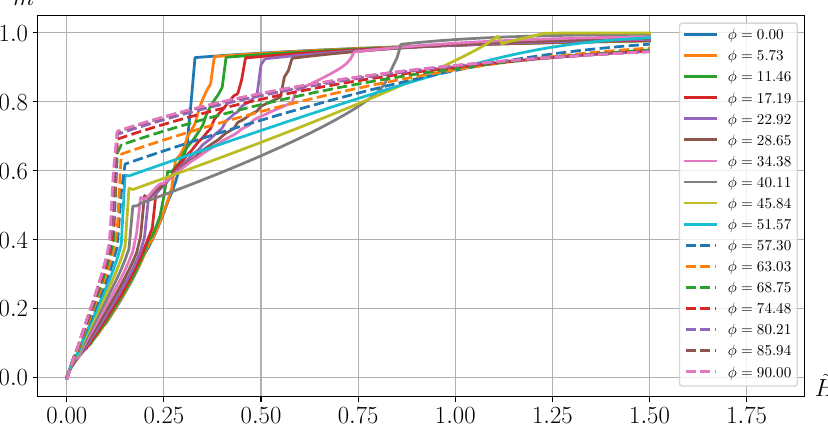
Figure 2. Dependences of the average value of the magnetization projection on the axis along which the external magnetic field is directed on the applied field for different directions of application of the external magnetic field φ (in